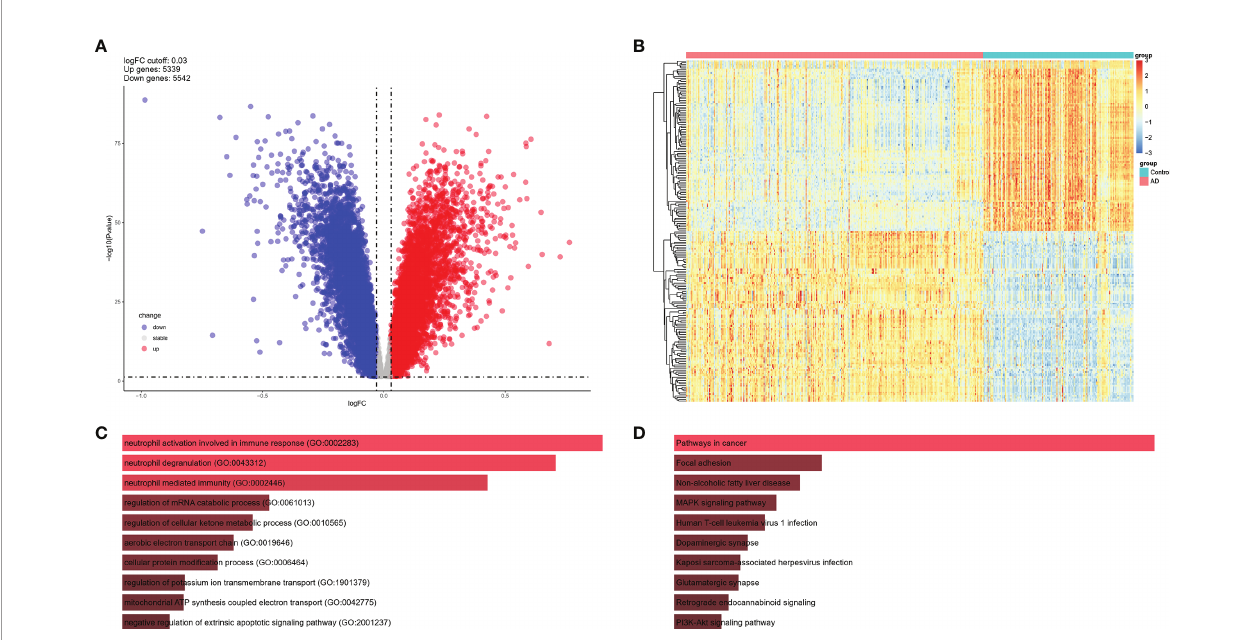
FIGURE 4 | DEGs of AD brain from GSE33000 dataset. (A) Volcano plot of DEGs (|logFC| > 0.03 and adjusted P value < 0.05). Up-regulated genes were colored in red and down-regulated genes were colored in blue. (B) Heatmap of top 100 up and top 100 down DEGs of GSE33000. (C) GO of DEGs in GSE33000. The top 10 GOs include neutrophil activation involved in immune response (GO:0002283), neutrophil degranulation (GO:0043312), neutrophil mediated immunity (GO:0002446), regulation of mRNA catabolic process (GO:0061013), regulation of cellular ketone metabolic process (GO:0010565), aerobic electron transport chain (GO:0019646), cellular protein modi fi cation process (GO:0006464), regulation of potassium ion transmembrane transport (GO:1901379), mitochondrial ATP synthesis coupled electron transport (GO:0042775), and negative regulation of extrinsic apoptotic signaling pathway (GO:2001237). (D) KEGG of DEGs in GSE33000. The top 10 KEGGs include Pathways in cancer, Focal adhesion, Non-alcoholic fatty liver disease, MAPK signaling pathway, Human T-cell leukemia virus 1 infection, Dopaminergic synapse, Kaposi sarcoma- associated herpesvirus infection, Glutamatergic synapse, Retrograde endocannabinoid signaling, and PI3K-Akt signaling